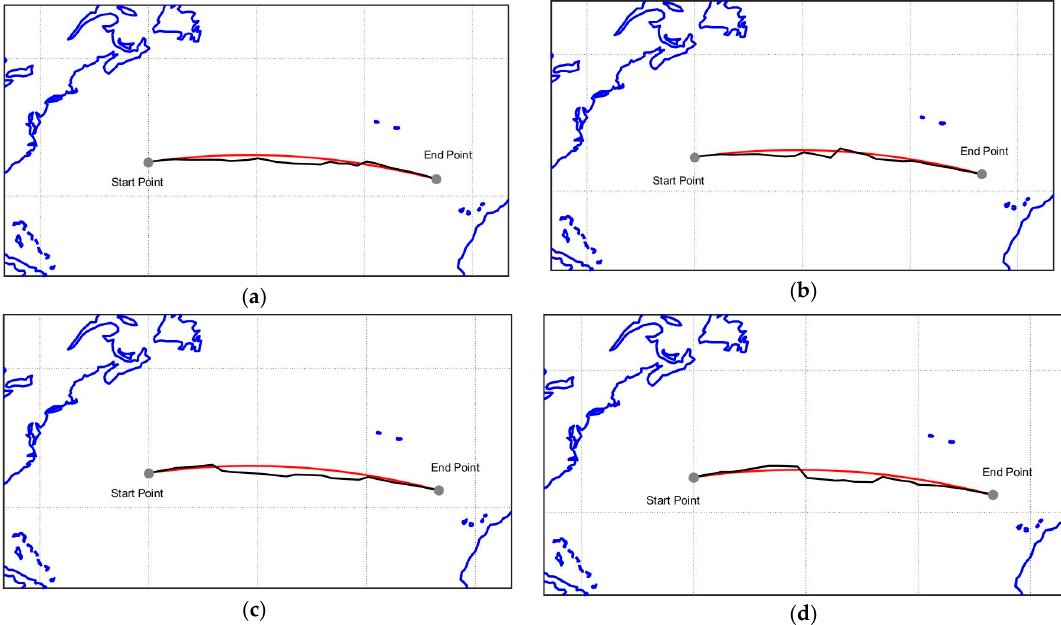
Figure 4. Minimum distance (great circle) and optimal route detection, F N = 0.15: ( a ) Case 1; ( b ) Case 2; ( c ) Case 3; ( d ) Case 4. Table 3. Results of optimal route detection, F N = 0.15.